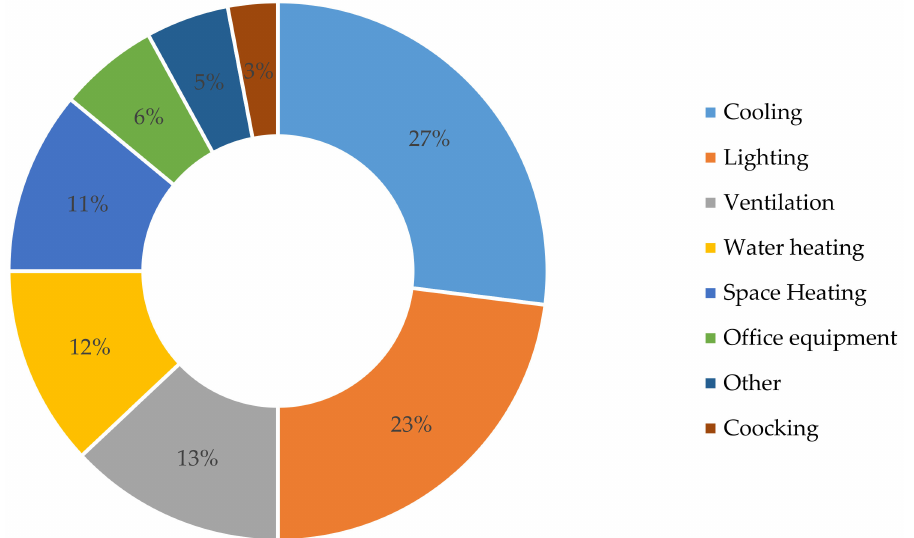
Figure 6. Structure of electricity consumption in the analyzed hotel facility.